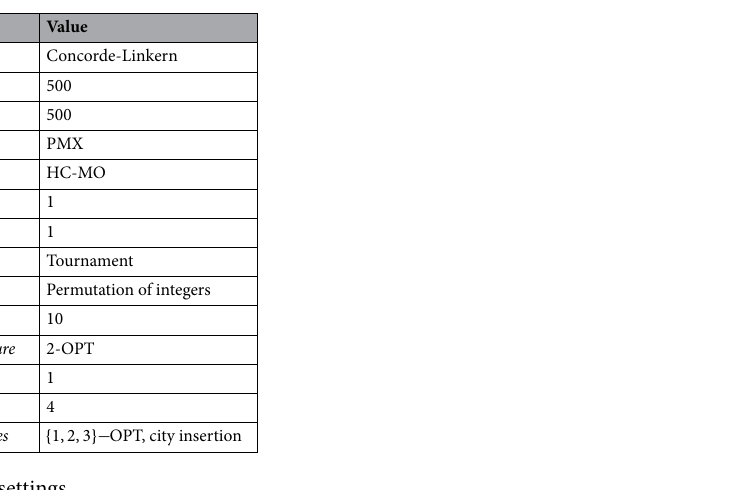
Table 1. Experimental settings.